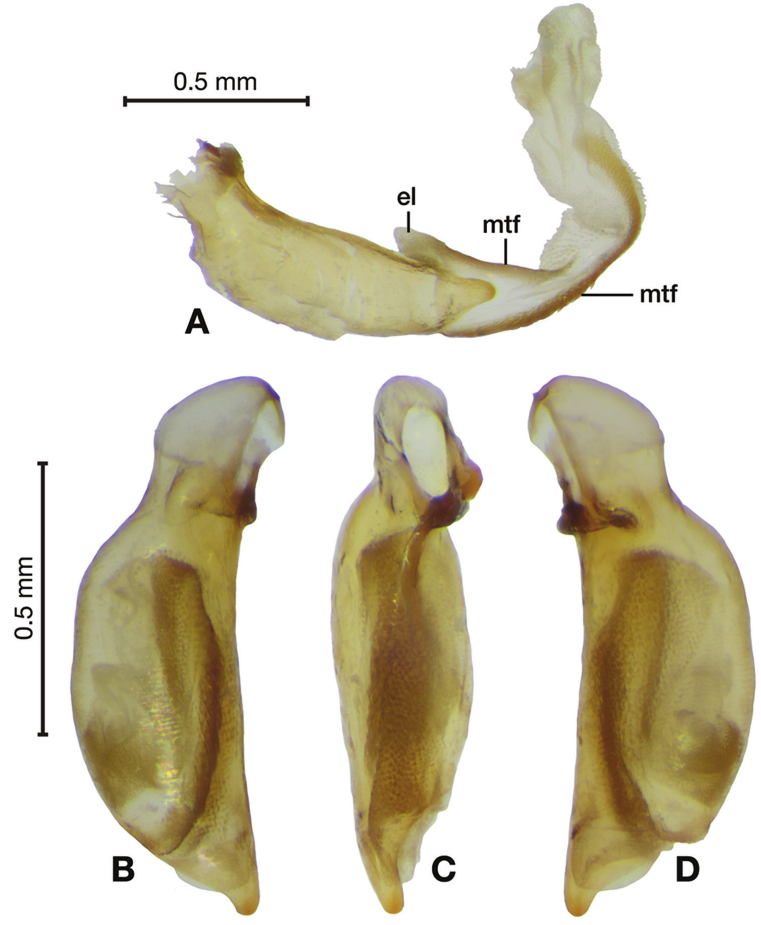
Figure 76. Digital images of male genitalia of Formosiella flavomaculata (Shibata). A dorsal aspect, en- dophallus everted B right lateral aspect C ventral aspect D left lateral aspect. Legend: el endophallic lobe; mtf microtrichial